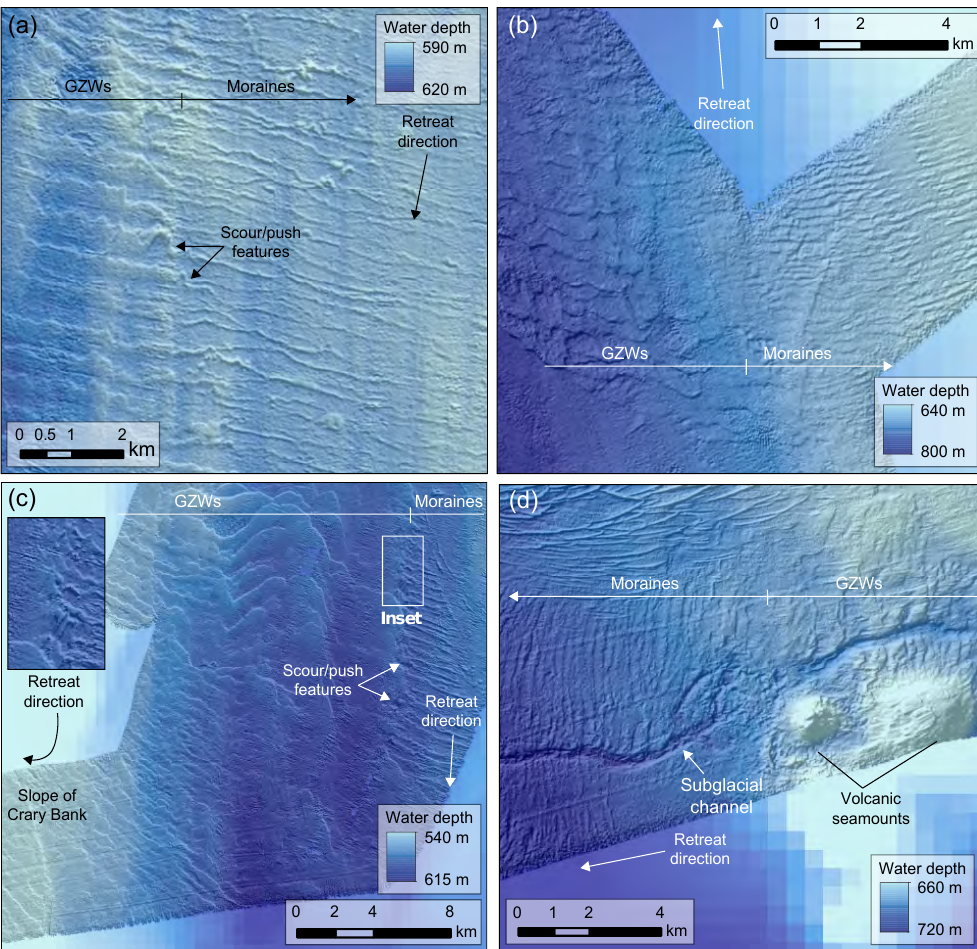
Figure 6. Recessional moraines and grounding zone wedges transition from clusters of one type to the other spatially (laterally: a–c ) and temporally (in retreat sequence: d ). Transitions occur across a variety of topographic settings (troughs: a , d ; slopes: b , c ), with contrasting water depth–landform type relationships, and show contrasting arrangement of individuals within a cluster, from well-spaced individuals (a) to stacked, overlapping wedges (c)